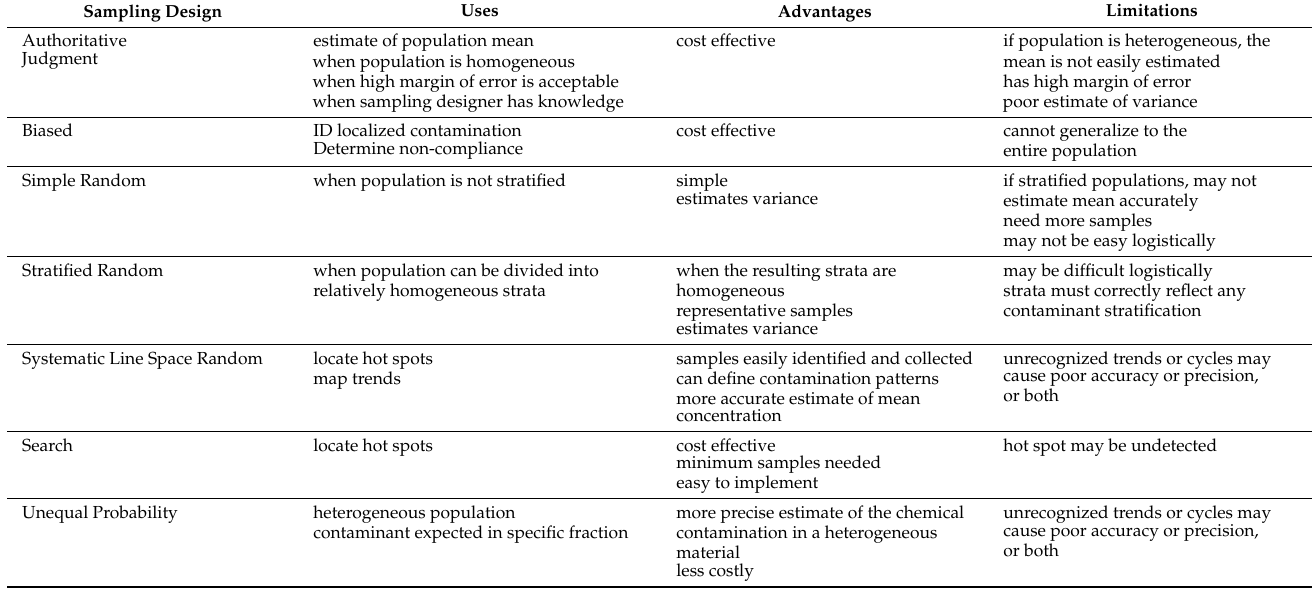
Table 2. A summary of advantages and limitations of the most common sampling designs from ASTM D6311